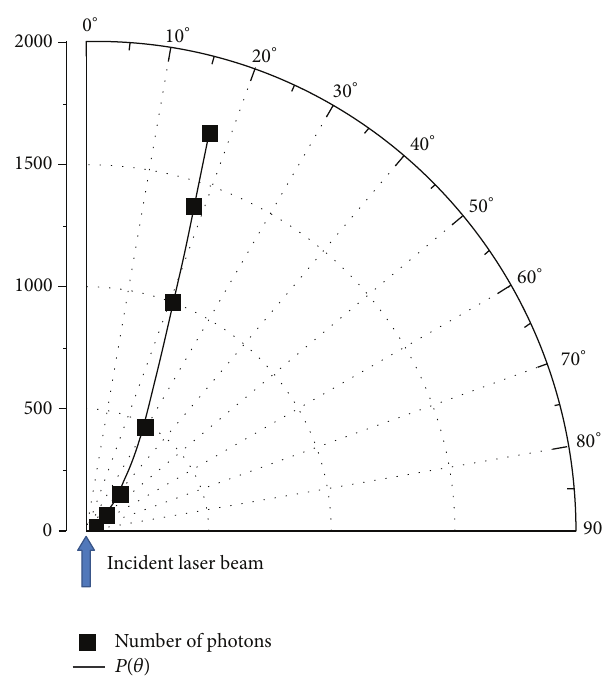
Figure 4: Dependence of the photon number counter on angle 𝜃 . Experimental results are marked with squares; line is HG function for 𝑔 = 0.83 .